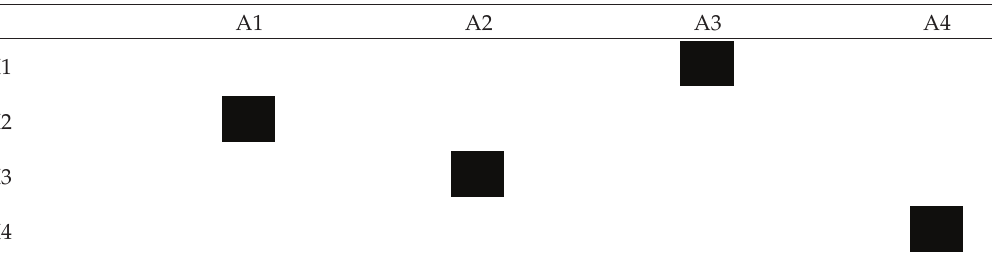
Figure 6: Example of state array. Table 3: Example of a job with 4 actions on 4